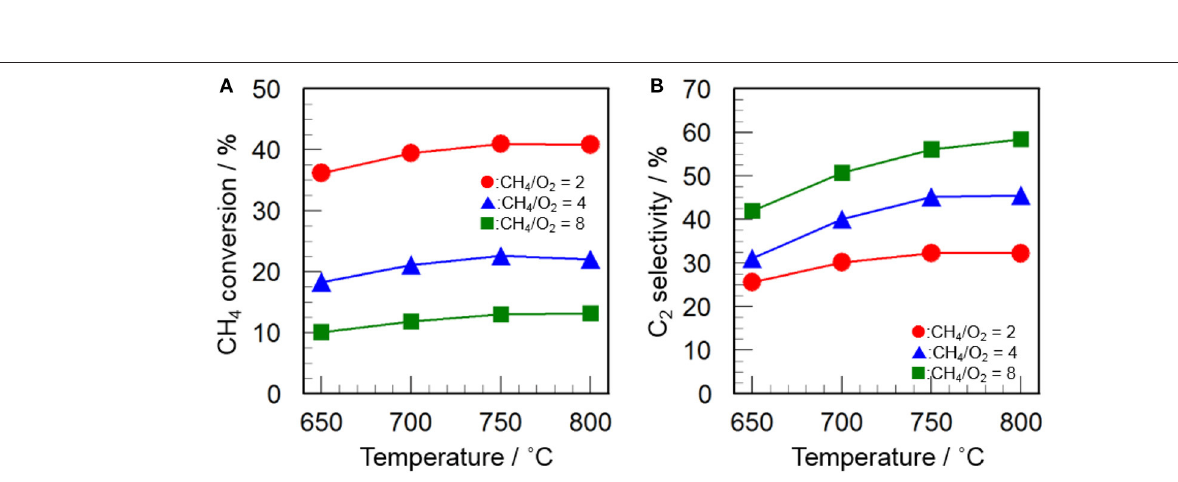
FIGURE 6 | Effect of CH 4 /O 2 ratio on (A) CH 4 conversion and (B) C 2 selectivity in the OCM reaction over CeO 2 ( 3 )/Y 2 O 3 (CP). (Red circles) CH 4 /O 2 = 2, (blue triangles) CH 4 /O 2 = 4, (green squares) CH 4 /O 2 =